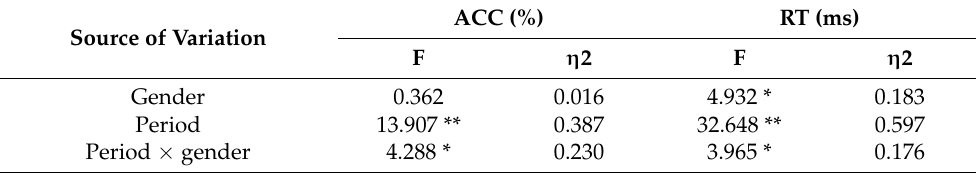
Table 3. Behavioral variance (ANOVA) analysis of the effect of orienteering exercises on spatial memory ability of college students of different genders. (F represents the results of the ANOVA test, where the correct rate of motor intervention time, and gender repeated-measures ANOVA interaction was significant; the gender at response, and motor intervention time repeated-measures ANOVA interaction was